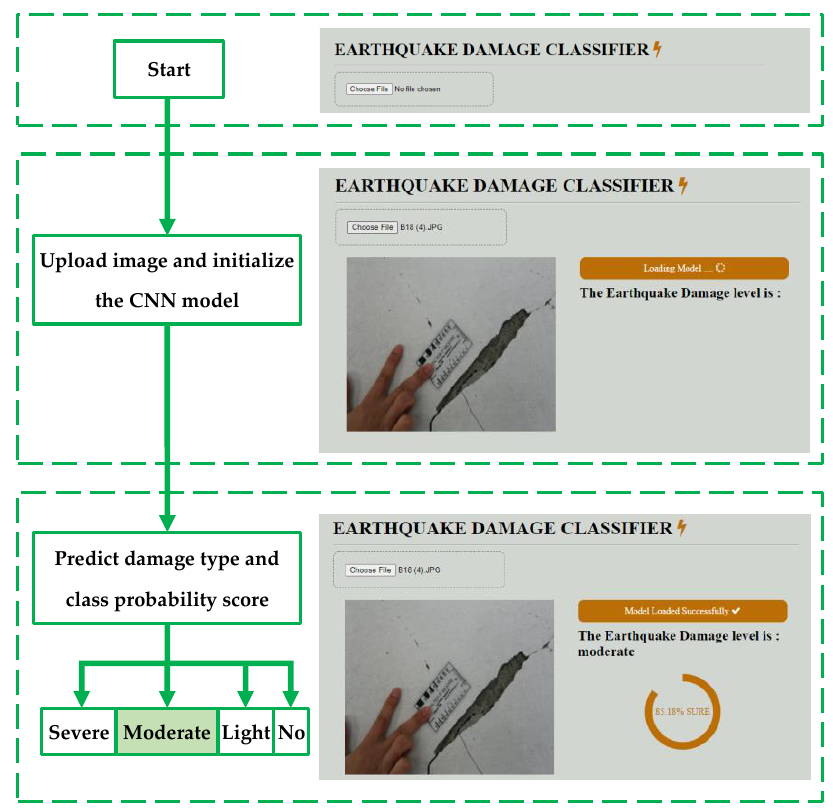
Figure 14. Graphical user interface for web-based application that integrates optimal MobileNet damage classifier model.